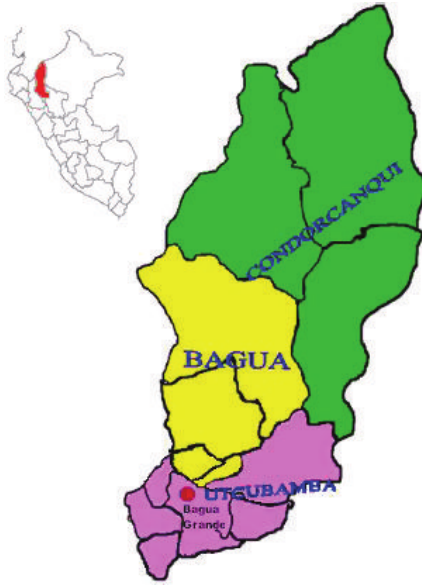
Figure 2: Location of the sampled areas in Bagua Grande (red spot), province of Utcubamba, department of Amazonas, Peru. At left top, map of Peru with location of department (filled in